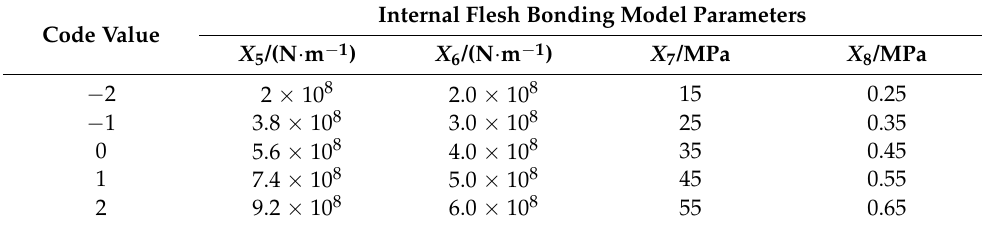
Table 6. Internal flesh bonding model parameter codes.